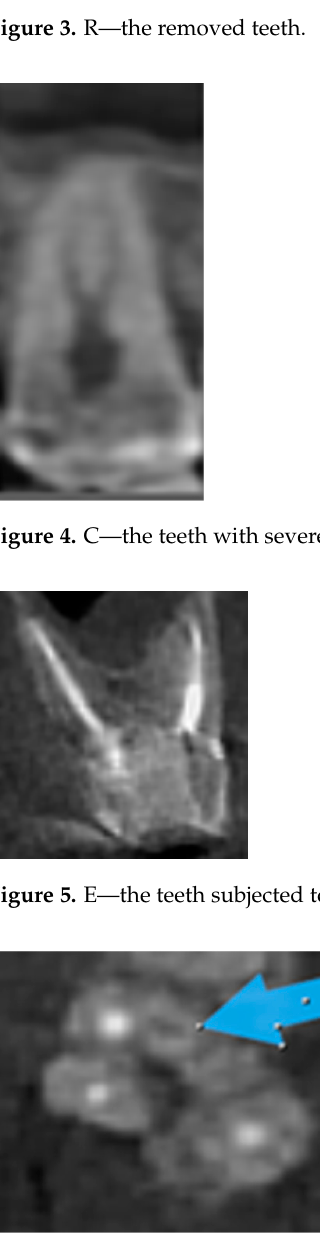
Figure 6. NE—the teeth subjected to unsuccessful endodontic treatment.